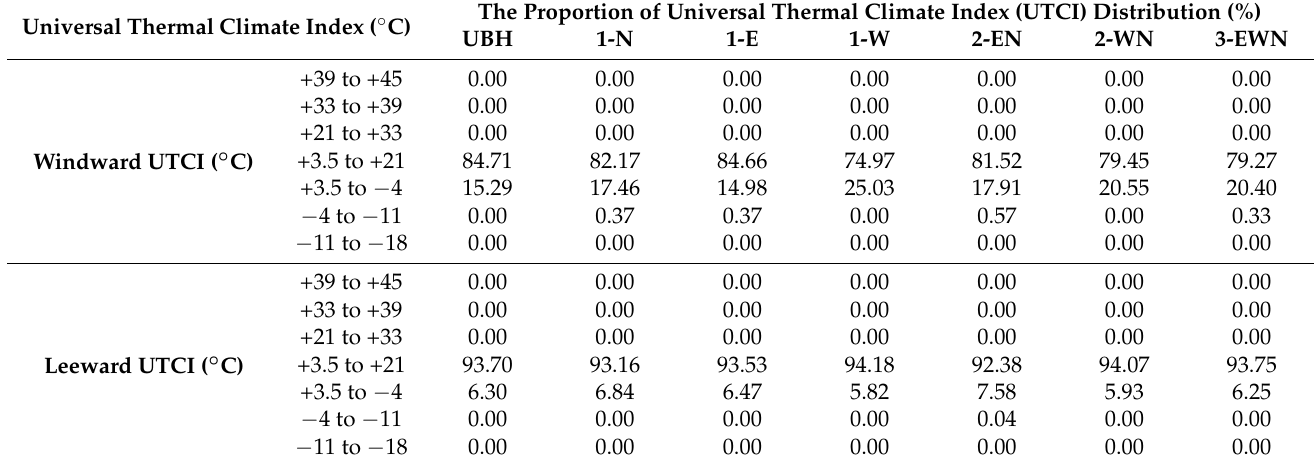
Table 6. Distribution table of UTCI ratio of seven building distribution modes.